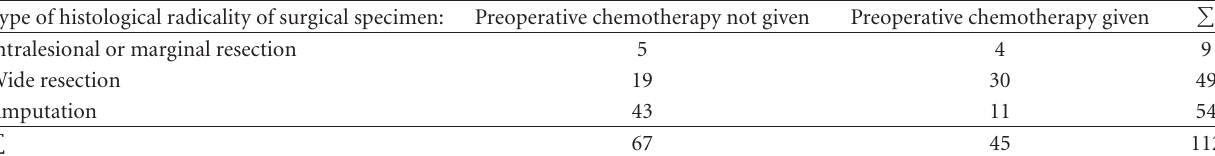
Table 2: Histological radicality of surgery in relation to preoperative chemotherapy course a . P value b = . 00002. Type of histological radicality of surgical specimen: